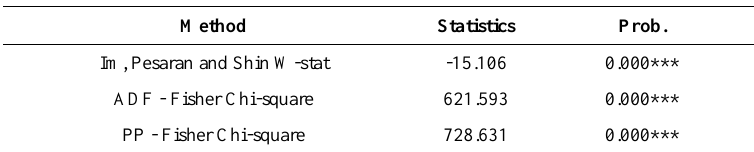
Table 2. Unit Root Test.